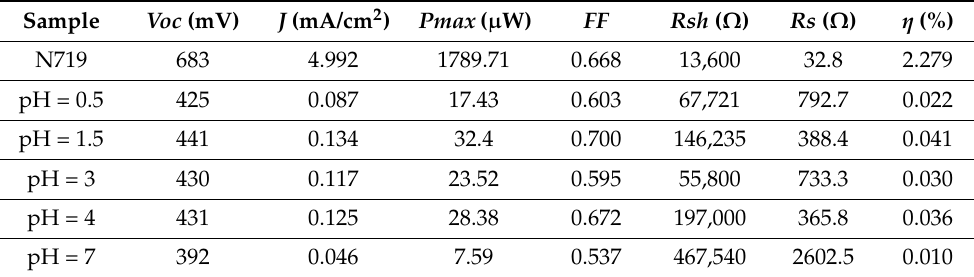
Figure 12. I - V curves of DSSCs prepared with the roselle calyx extracts with different pH values, in comparison with a reference DSSC. Table 3. Electrical characteristics of the solar cells prepared from the roselle calyces extracts, in comparison with a DSSC based on